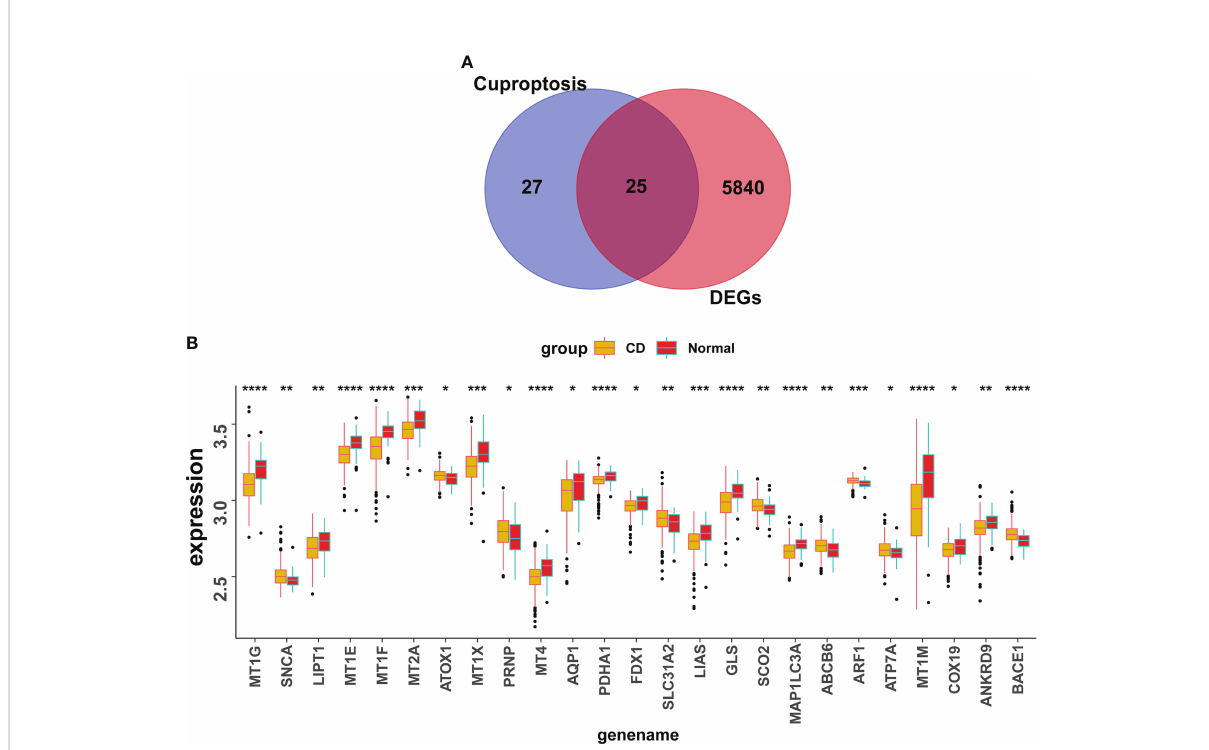
FIGURE 4 Screening of the CuDEGs in CD. (A) The overlap of genes between DEGs and cuproptosis-related genes. (B) Overall expression histogram of CuDEGs in CD patients. CuDEGs; differentially expressed cuproptosis-related genes. * represents p < 0.05, ** represents p < 0.01; *** represents p < 0.001;